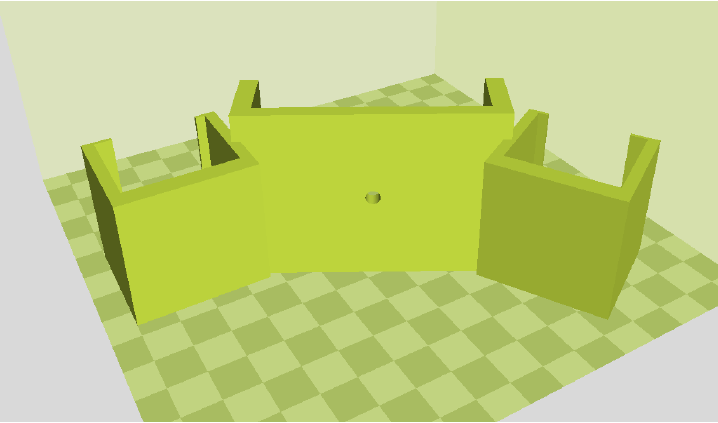
Figure 4. Rendering of OpenSCAD solid model for the solar PV module holders for the MOST delta RepRap PV conversion kit. Two holders are mounted at the bottom and top of each of the three vertical supports of the delta for a total of six holders using wood screws.